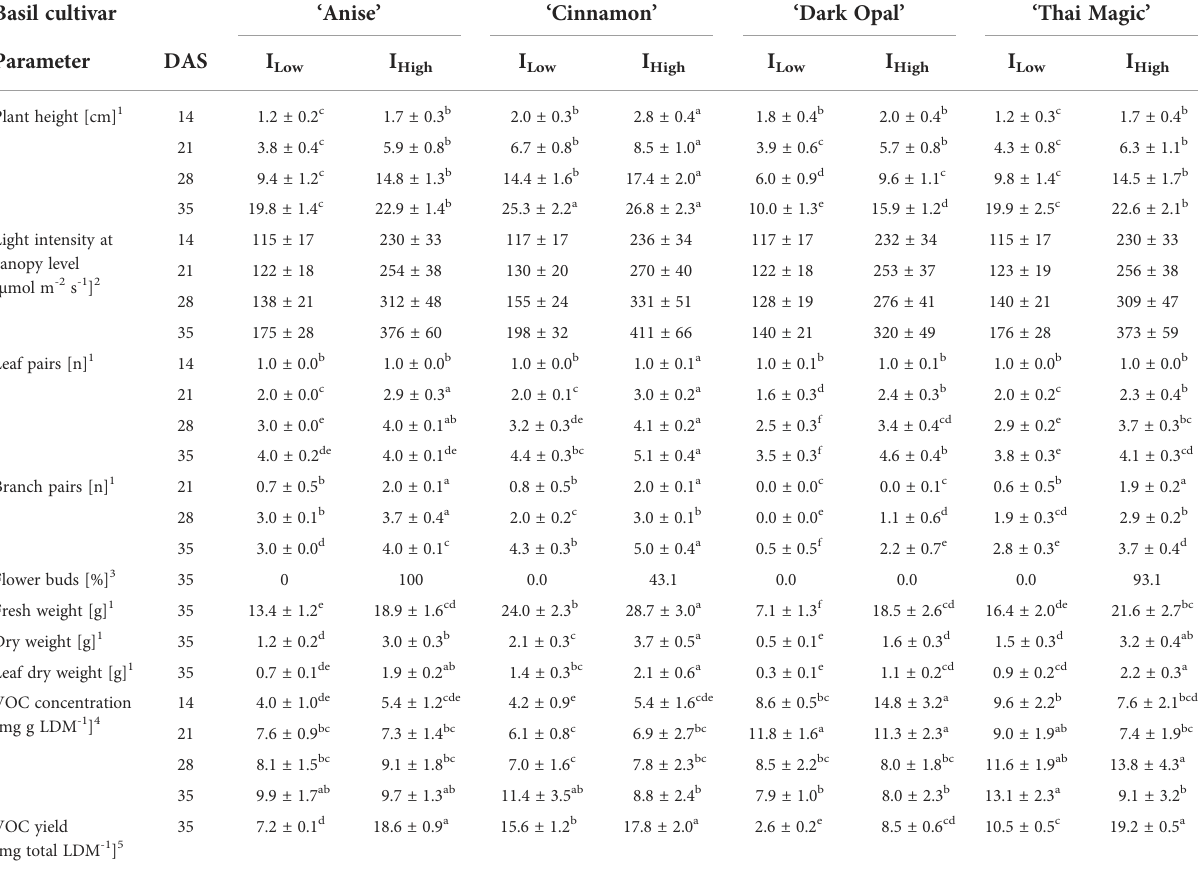
TABLE 2 Summarized plant characteristics of four basil cultivars grown under two LED light intensities over time (including light intensities at plant canopy levels). Basil